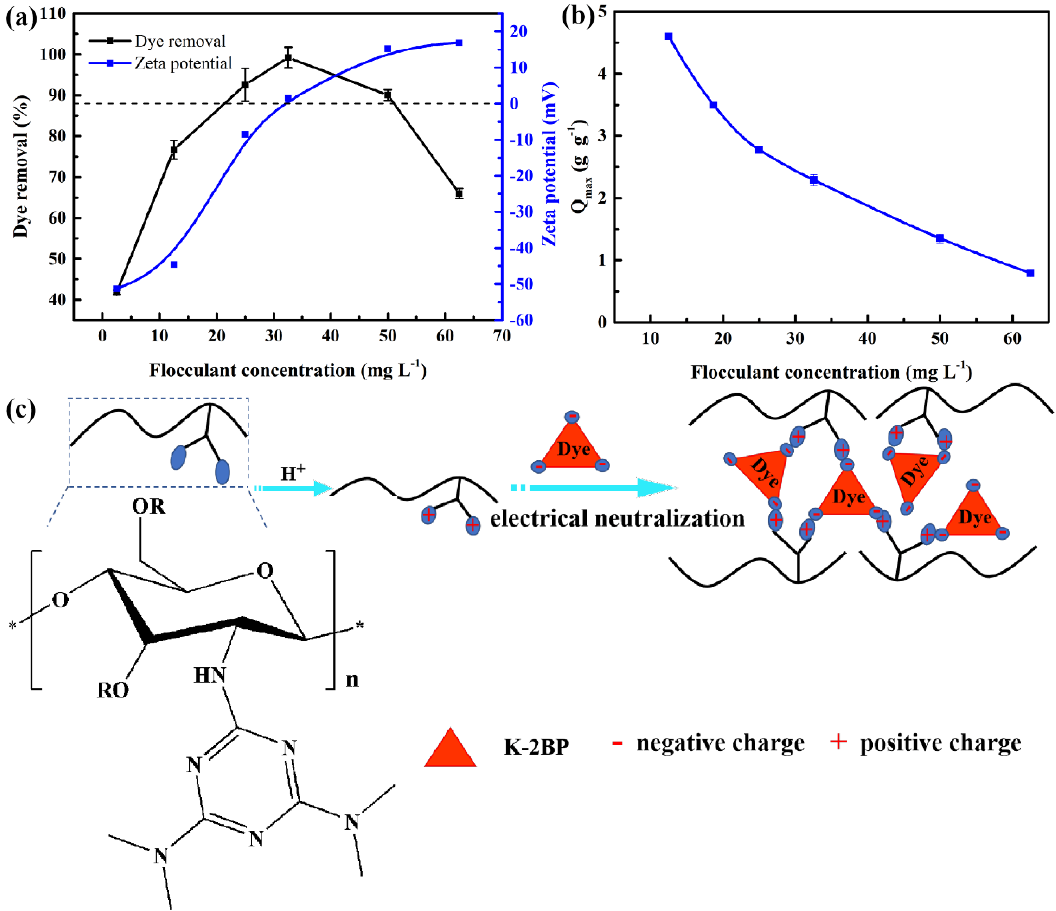
Figure 1. ( a ) Effect of the flocculant concentration on color removal and zeta potential. ( b ) Effect of the flocculant concentration on the flocculation capacity. ( c ) Schematic presentation of the flocculation mechanism of the flocculant.